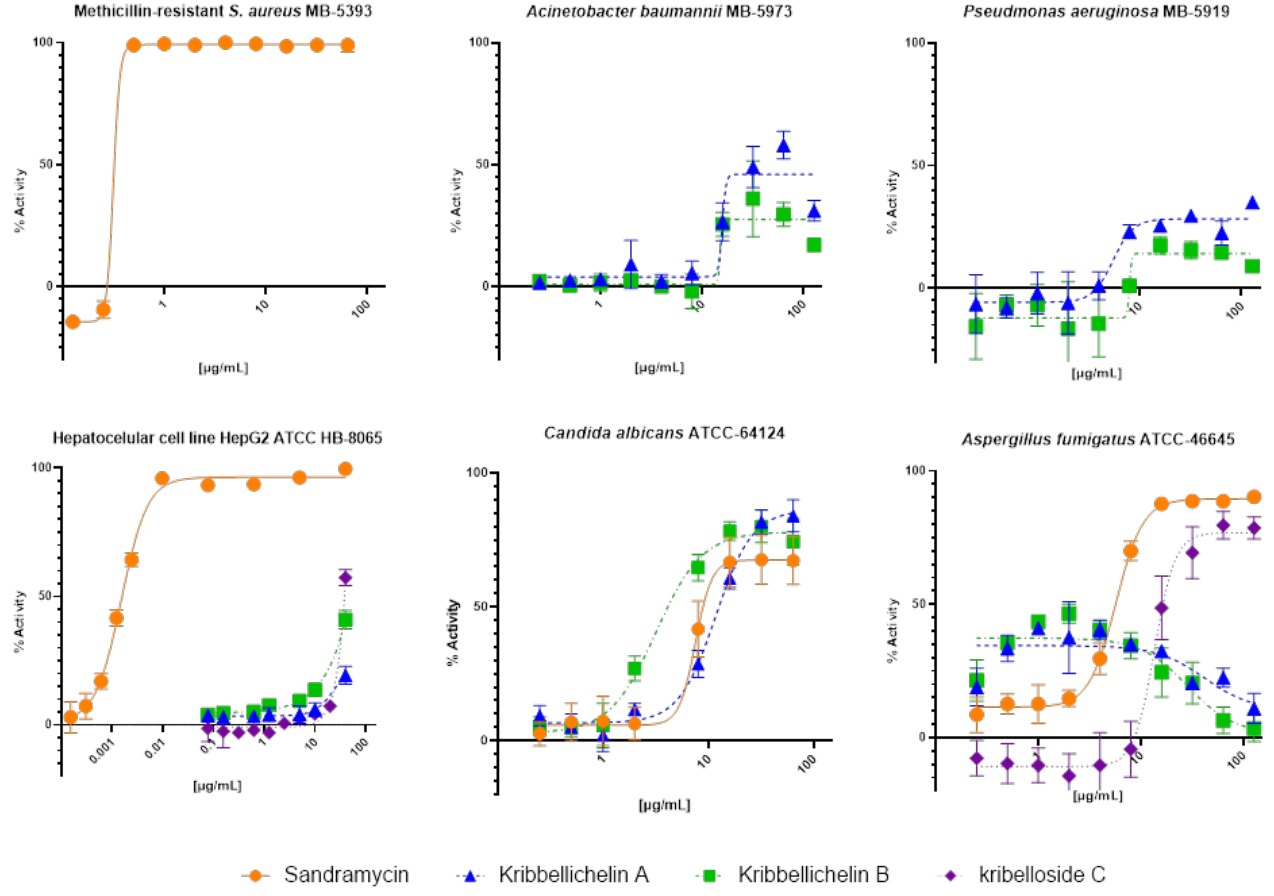
Figure 4. Antimicrobial/cytotoxic activity of compounds 1 – 3 and 5 against MRSA MB-5393, A. baumannii MB-5973, P. aeruginosa MB-5919, HepG2 (ATCC HB-8065), A. fumigatus ATCC-46645, and C. albicans ATCC-64124.